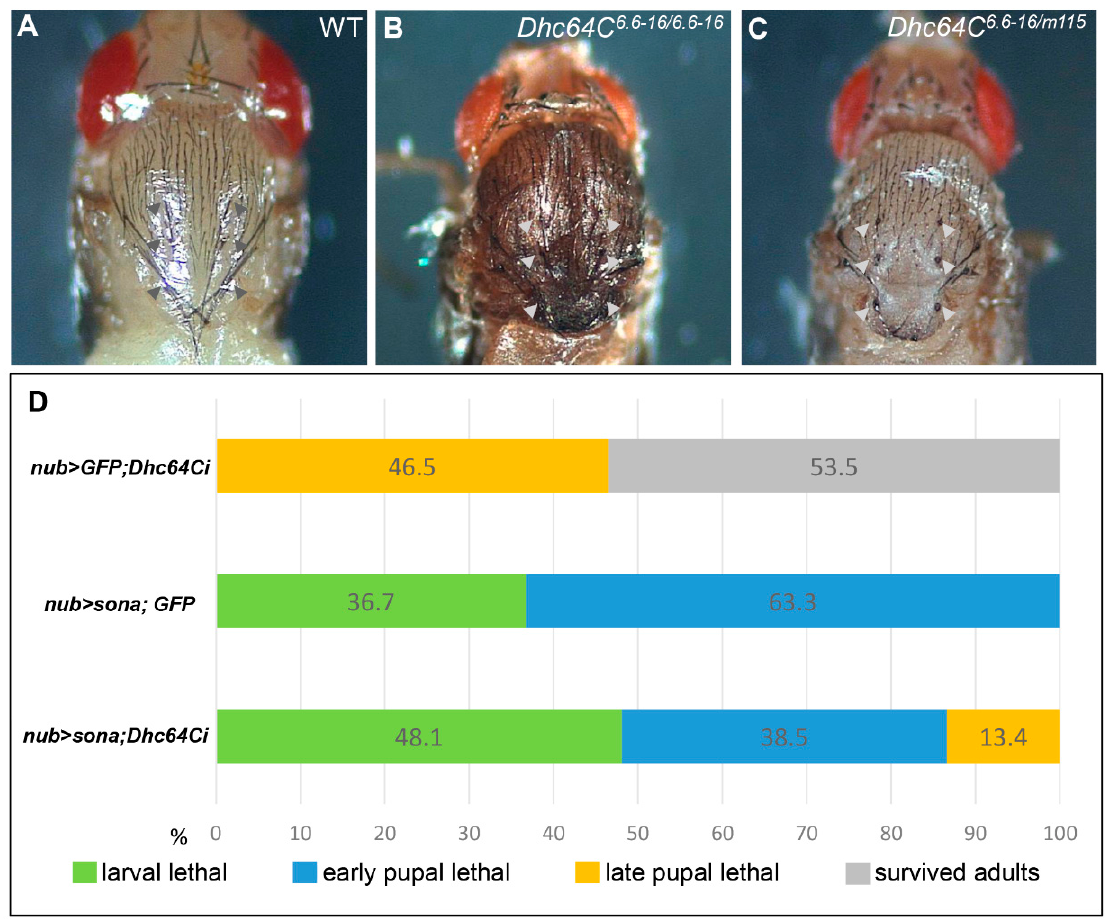
Figure 2. Dhc64C has a positive genetic interaction with sona . ( A – C ) Scutellar bristles are defective in Dhc64C mutants. The normal scutellum of wild type Canton-S ( CS ) pupae (( A ), arrowheads). Scutellar bristles are short and disrupted in hypomorphic Dhc64C 6.6 − 16/6.6 − 16 adults (( B ), arrowheads) and transheterozygous Dhc64C 6.6 − 16 /Dhc64C m115 pharate adults (( C ), arrowheads). ( D ) Knockdown of Dhc64C partially rescues Sona-induced lethality. Fly genotypes and developmental states in percentages are shown.